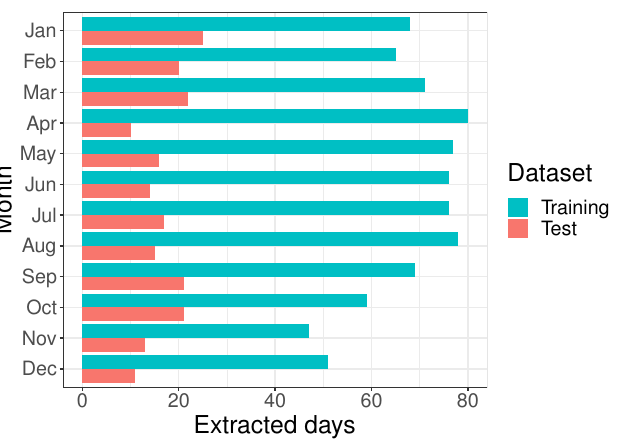
Figure 3. Distribution of the training and test sets which was selected to contain an equal distribution across meteorological seasons to account for seasonal variation in cloud dynamics within the